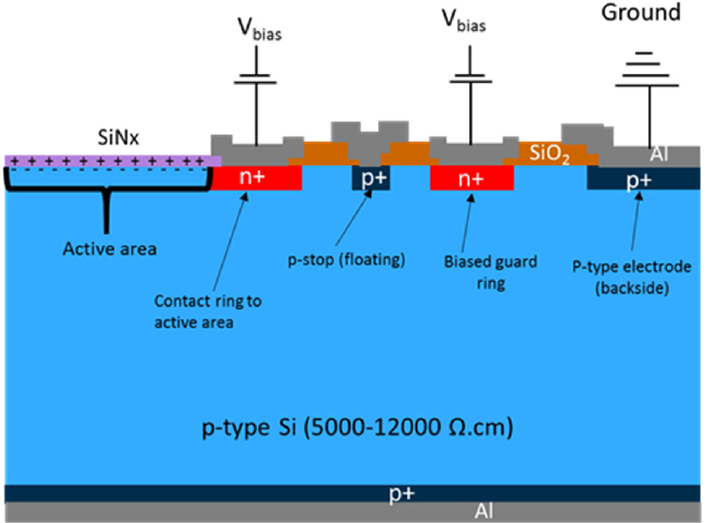
Figure 1. Inversion layer photodiode structure and biasing scheme. The n+ and p+ regions, formed by phosphorous implantation and boron implantation, respectively, have peak doping concentrations of >10 19 cm − 3 and profile depths of ~2 µm.